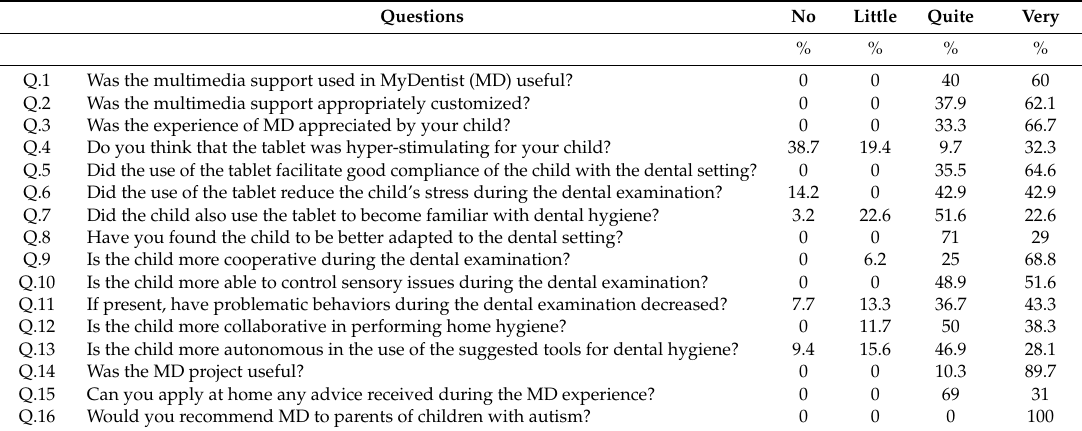
Table 3. Percentage of parents’ answers to Questionnaire B.